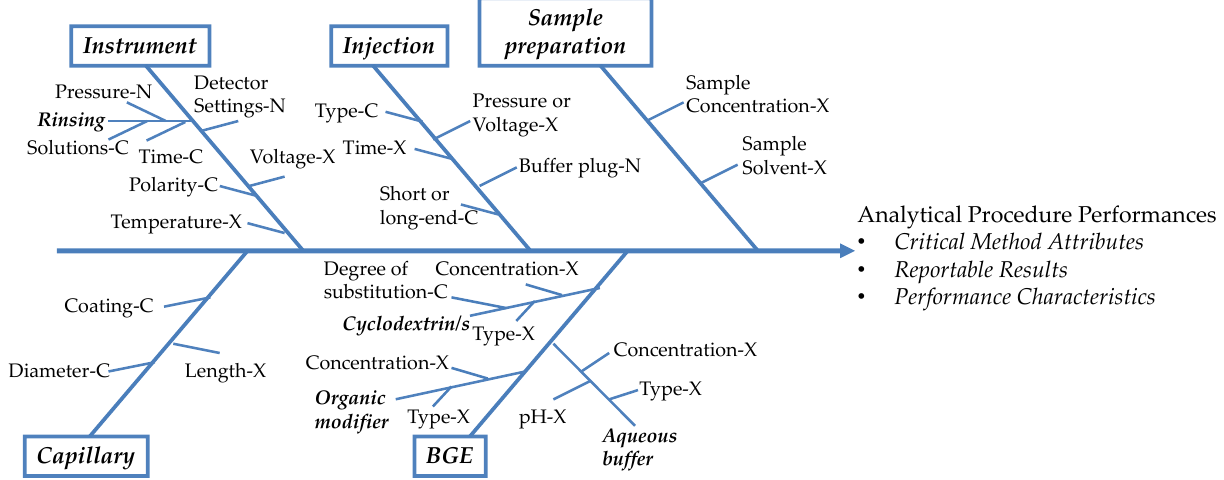
Figure 5. Ishikawa diagram for a generic CZE method. Analytical procedure parameters: C — controlled factor, N — noise facto, and X — experimented factor.